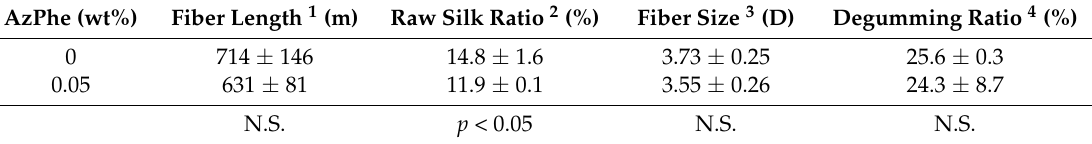
Table 1. Characterization of raw silk fiber reeled from the cocoons of the F 1 hybrid, H06 × (Nichi509 × Nichi510), reared on a normal or an AzPhe-containing diet. Eighty larvae, including both male and female, were used for each experiment. AzPhe (wt%) Fiber Length 1 (m) Raw Silk Ratio 2 (%) Fiber Size 3 (D) Degumming Ratio 4 (%) 0 714 ± 146 14.8 ± 1.6 3.73 ± 0.25 25.6 ± 0.3 0.05 631 ± 81 11.9 ± 0.1 3.55 ± 0.26